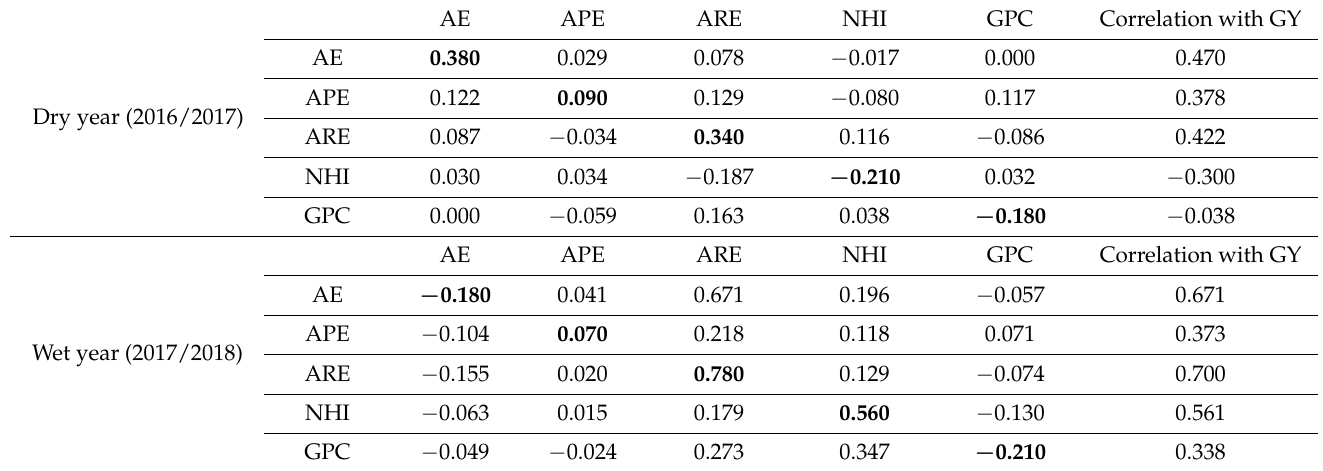
Table 6. Path coefficient analysis of the direct and indirect effects of AE, APE, ARE, NHI and GPC in the dry year and wet year.